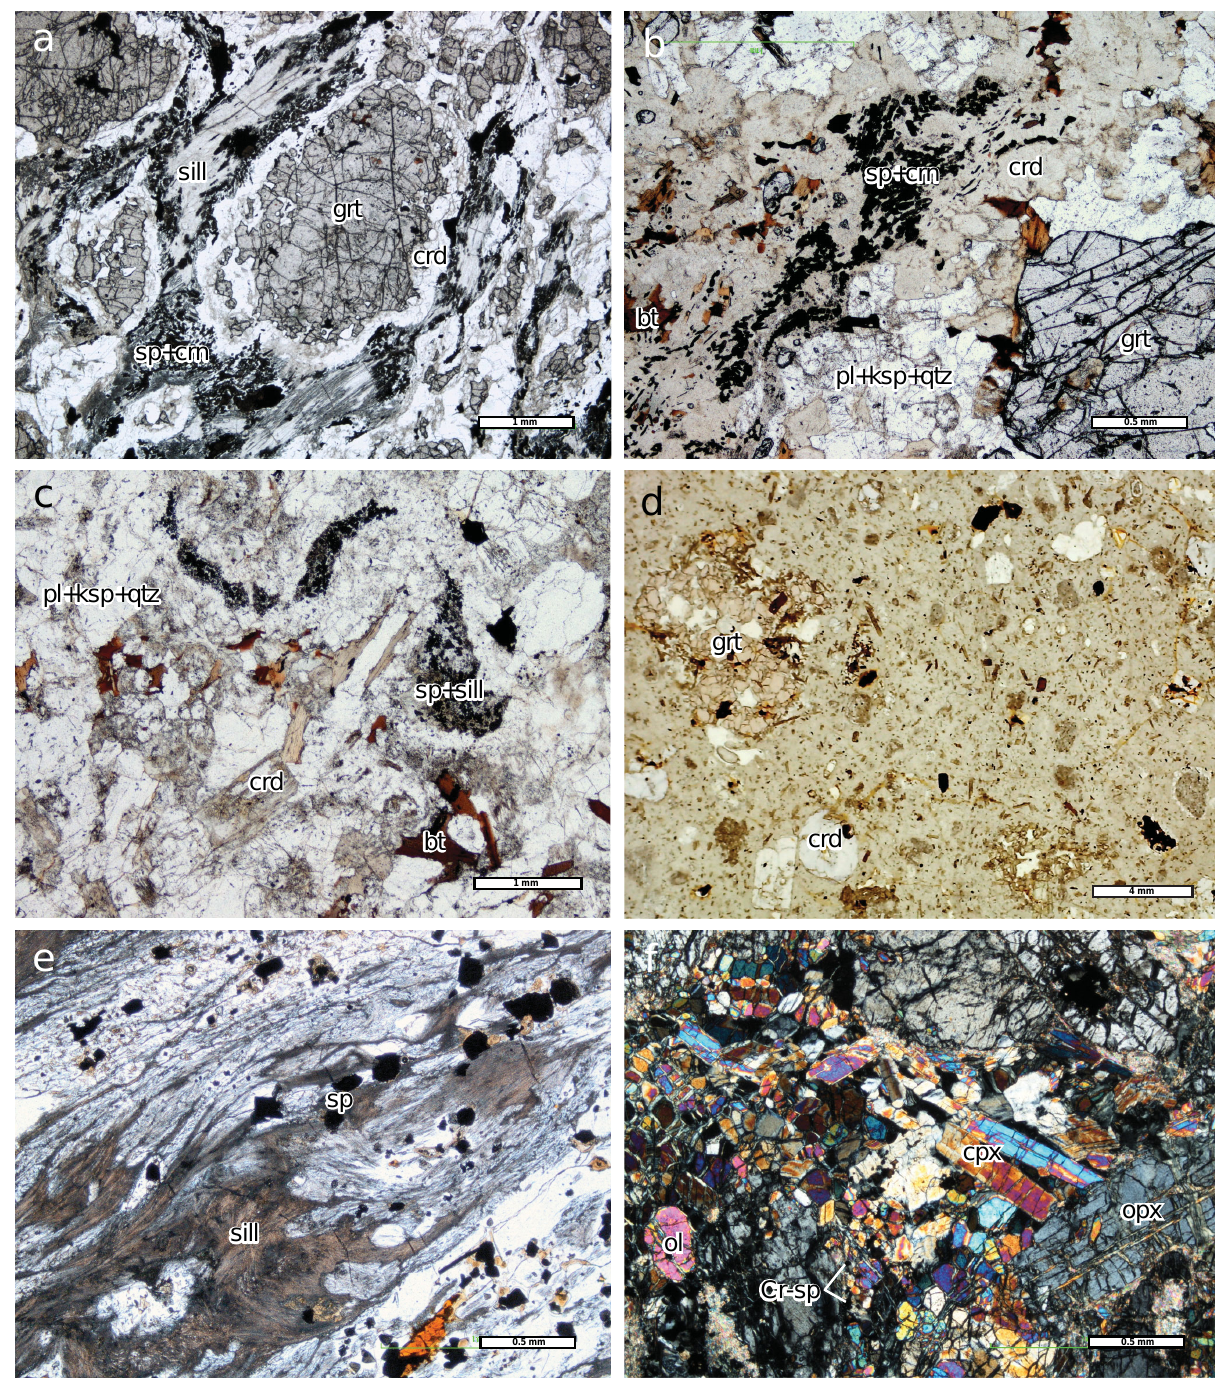
Fig. 18. (a–e) The migmatite–ambonite series of Seram and Ambon. Each rock in the sequence is “fingerprinted” by spinel+sillimanite assemblages and the presence of garnet and cordierite. (a) Highly residual (?U)HT garnet+cordierite+sillimanite+spinel+corundum + quartz granulite. (b) Metatexites containing some quartzofeldspathic domains but retaining the residual high-temperature assemblage present in (a) . Cordierite is almost completely pinitised. (c) “Cordierite granite” diatexite containing biotite and small schlieren of spinel+sillimanite. (d) Ambonite containing garnet and cordierite phenocrysts and granulite-derived xenoliths (e) containing mats of fibrolitic sillimanite with spinel which is associated with cordierite. These rocks (a–e) are representative of Kobipoto Complex rocks present throughout Seram and Ambon over a distance of a few hundreds of km – (a) and (b) are from the Kobipoto Mountains, (c) is from the Kaibobo Peninsula, and (d,e) is from northern Hitu. The heat source for the widespread high-temperature metamorphism and melting is exhumed lherzolite (f) shown in this example from the Wai Sapolewa, Kobipoto Mountains (outcrop shown in Fig.16c) to contain chrome spinel. Solid Earth, 4, 277–314, 2013